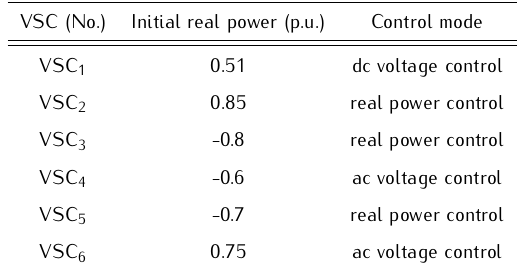
Table 1. Status of